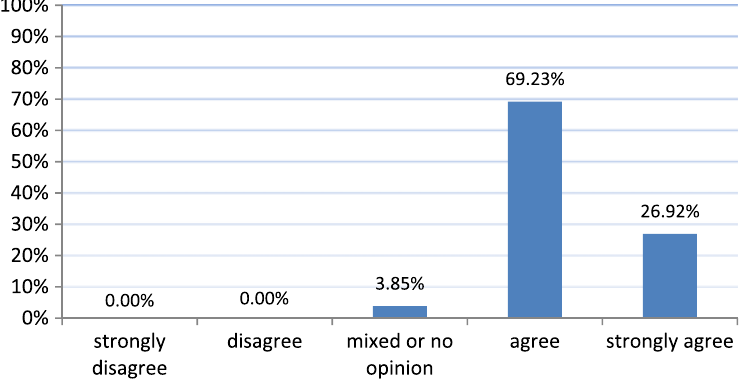
Figure 1. The university is flexible, dynamic and decisive in its decision making while remaining collegial and